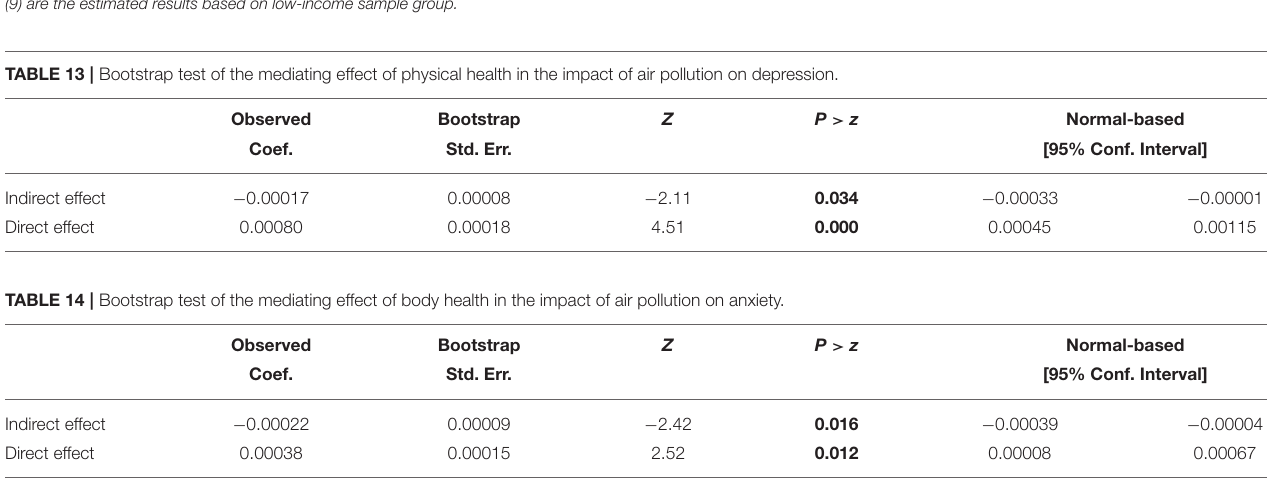
Happiness Physical Happiness Depression Physical Depression Anxiety Physical